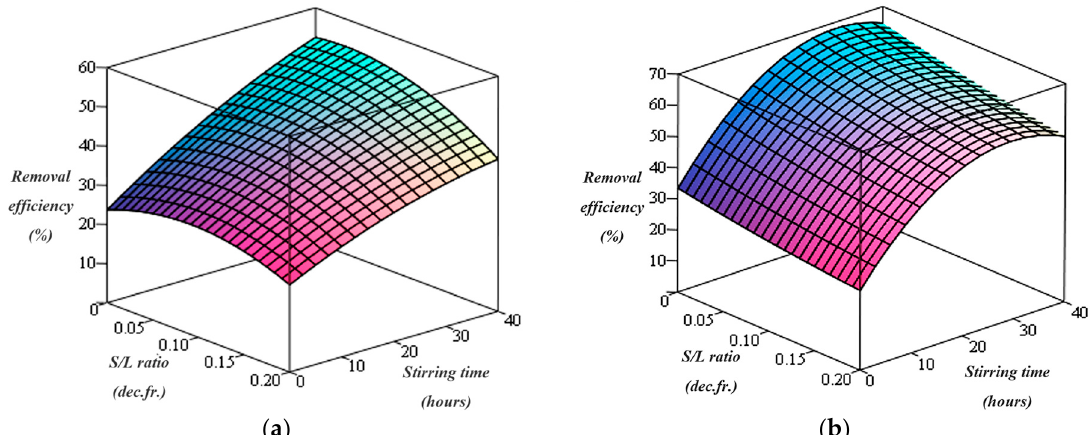
Figure 1. Cu removal efficiency using chitosan for ( a ) C = 2% and ( b ) C = 5%.